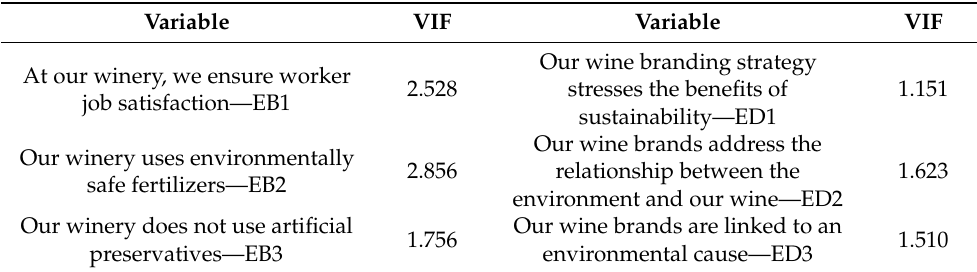
Table 4. Values of the collinearity coefficient of inflation variance (VIF).